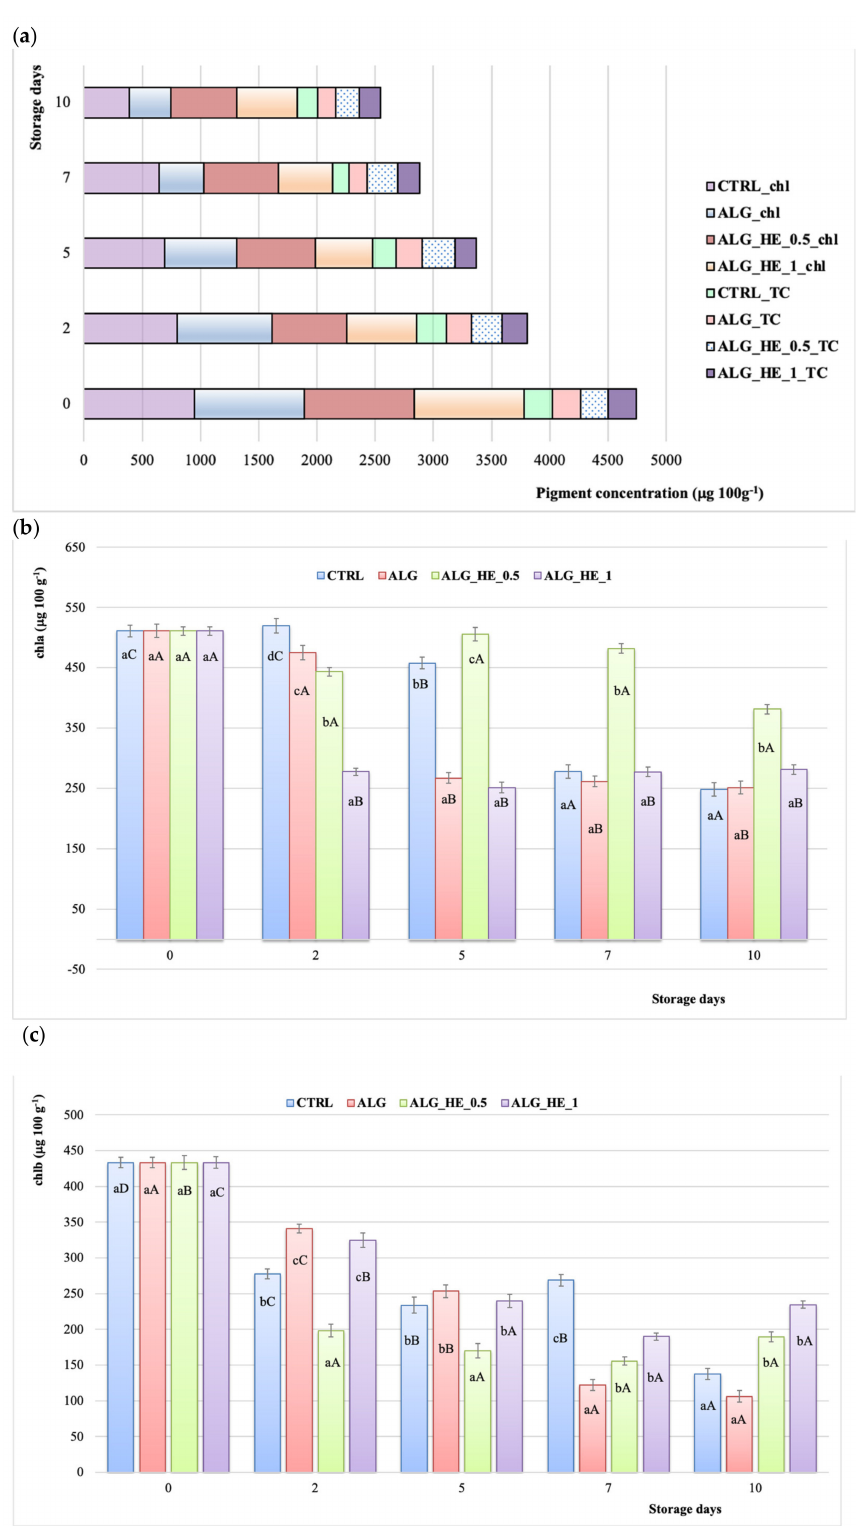
Figure 7. Changes in pigment content of fresh-cut kiwifruit underwent different treatments dur- ing storage at 4 ◦ C (mean ± sd; n = 5). ( a ) Total chlorophylls (chl) and total carotenoids (TC); ( b ) chlorophyll a content (chla); ( c ) chlorophyll b content (chlb). CTRL, control samples; ALG, algi- nate samples; ALG_HE_0.5, samples coated with alginate added with 0.5% of hop extract; ALG_HE_1, samples coated with alginate added with 1% of hop extract. Different lower-case letters indicate significant differences ( p < 0.05) among treatments at the same storage time. Different upper-case letters indicate significant differences ( p < 0.05) in each treatment over the storage